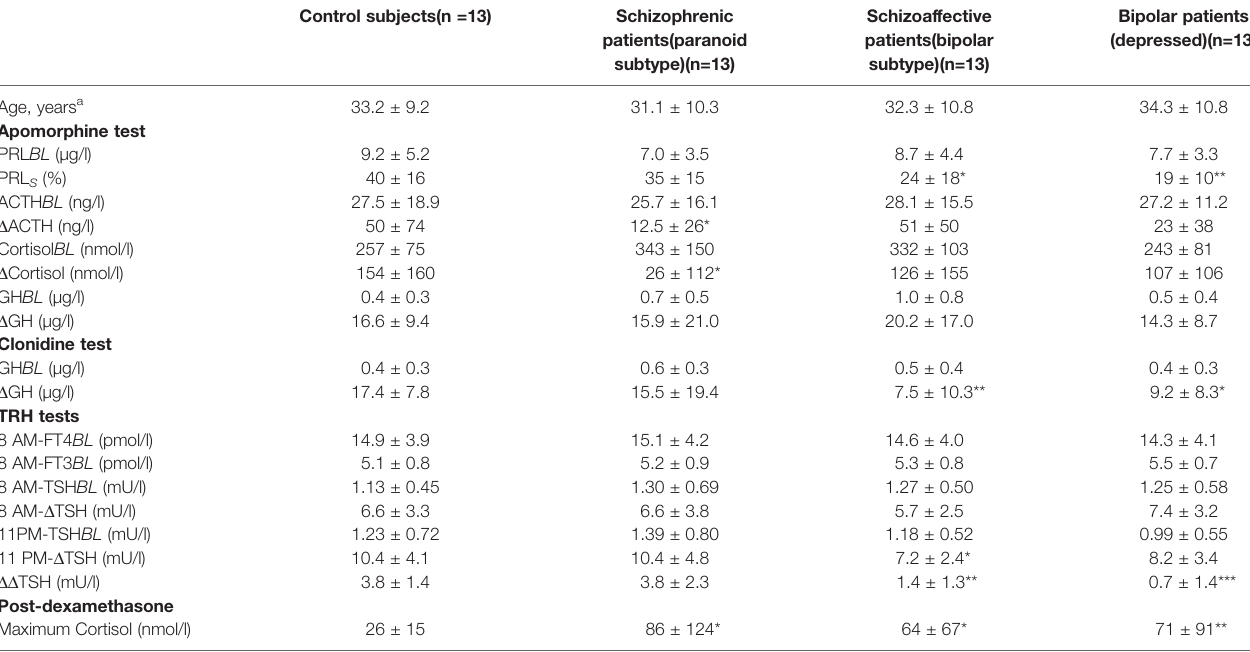
TABLE 1 | Demographic characteristics and biological data for normal controls and